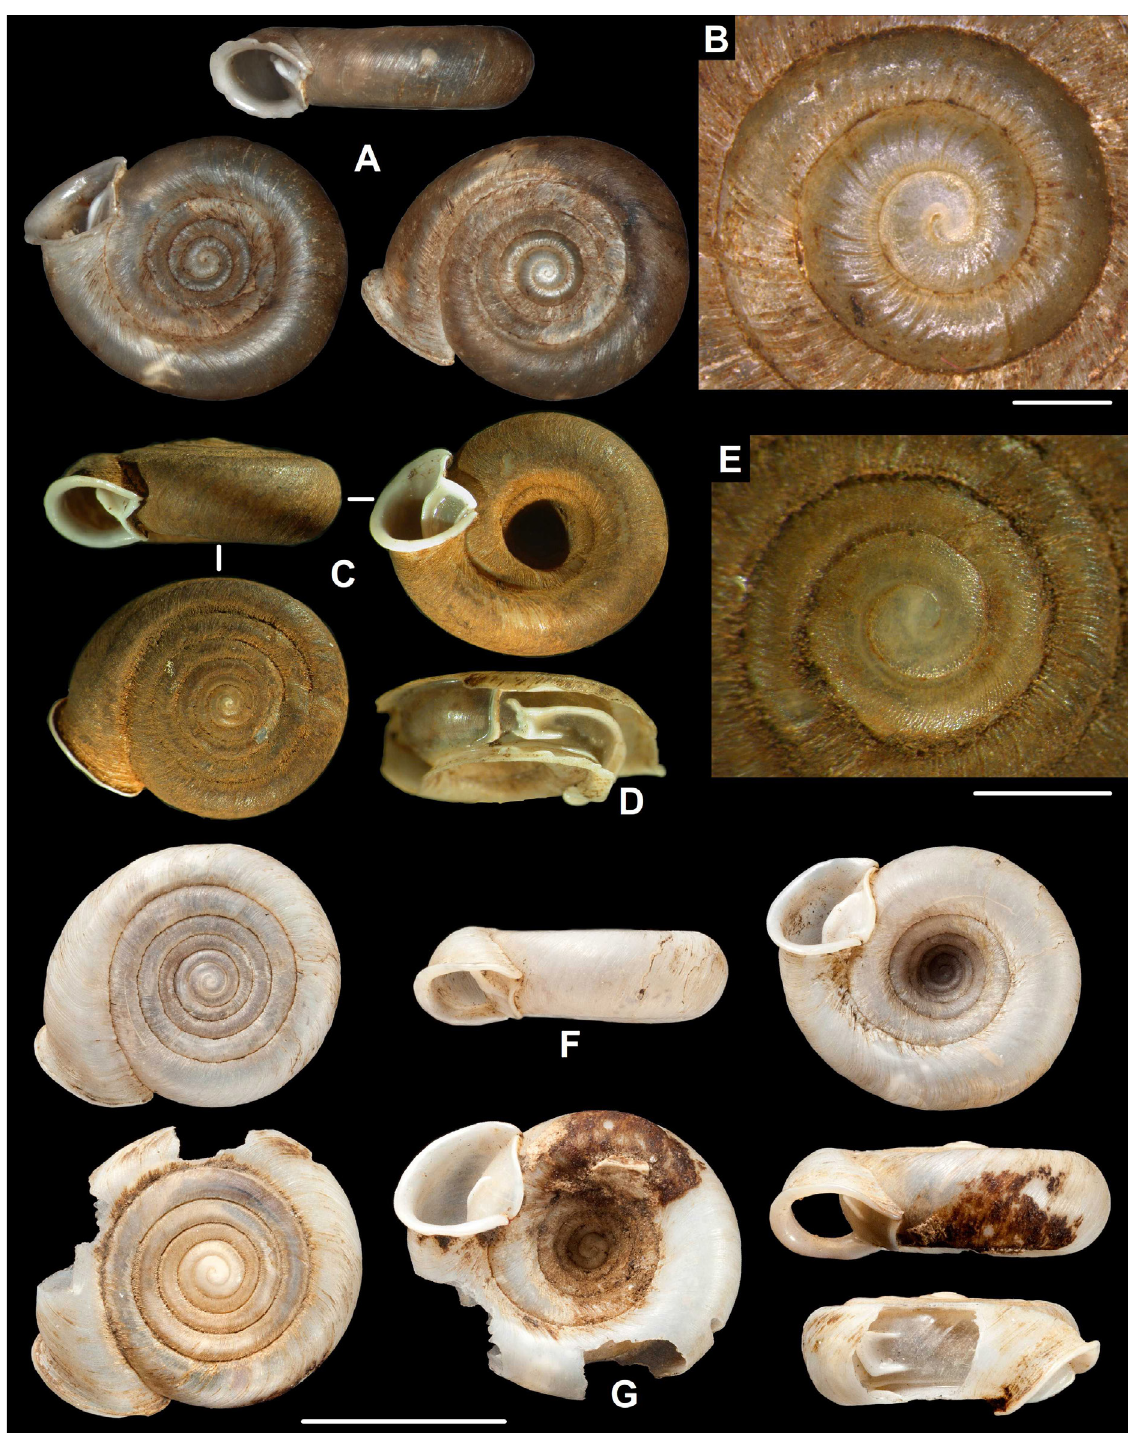
Fig. 14. Shells and protoconchs of species of Chersaecia Gude, 1899. A–B . C. auffenbergi sp. nov., holotype (UF 345566). C . C. goniobathmos (Ehrmann, 1922) comb. nov. , lectotype (SMF 150100a). D–E . C. goniobathmos , paralectotype (SMF 150100c). F . C. feddeni (Blanford, 1865) comb. nov., syntype (NHMUK 1906.1.1.730). G . C. feddeni , holotype of P. ponsonbyi (Godwin-Austen, 1888) syn. nov. (NHMUK 1913.3.14.9). Scale bars: A, C–D, F–G = 10 mm; B, E = 1 mm. Photos: T. Deli (A), B. Páll-Gergely (B–E), H. Taylor